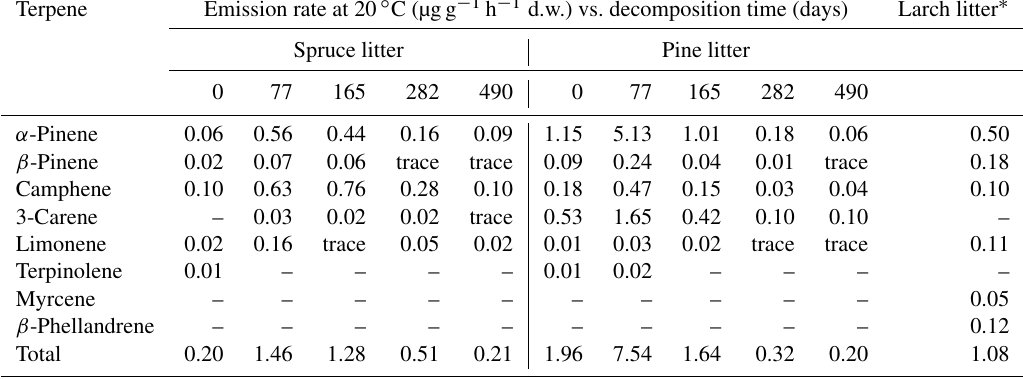
Table 6. Laboratory measurements of emission rates of monoterpene hydrocarbons from fresh and decaying litter of Norway spruce and Scots pine (Isidorov et al., 2010), as well as from fresh litter of European larch, Larix decidua (Isidorov et al.,